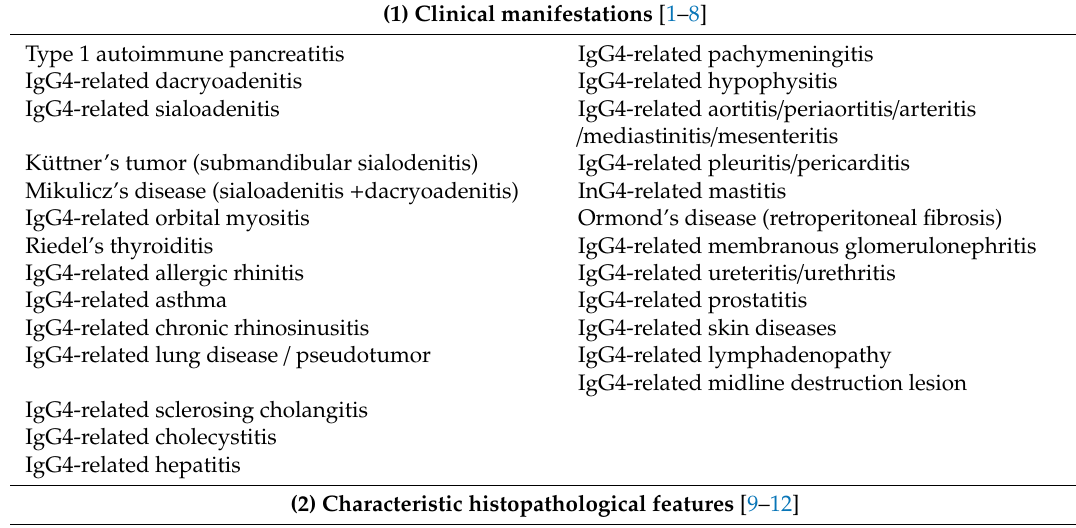
Table 1. A wide range of protean clinical manifestations and characteristic histopathologic findings in patients with IgG4-related